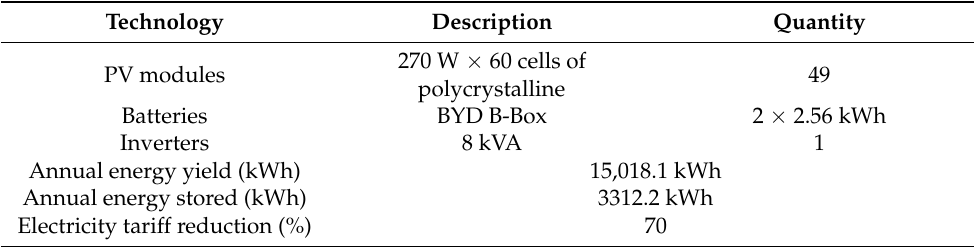
Table 6. BESS Botha Huis, Mosselbay, South Africa.